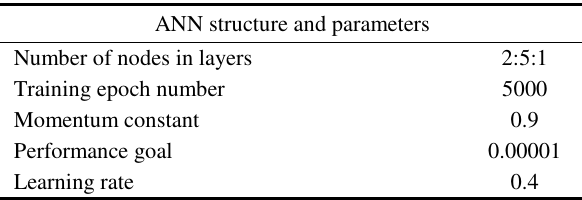
Table 1. The final architecture of the ANN model in the